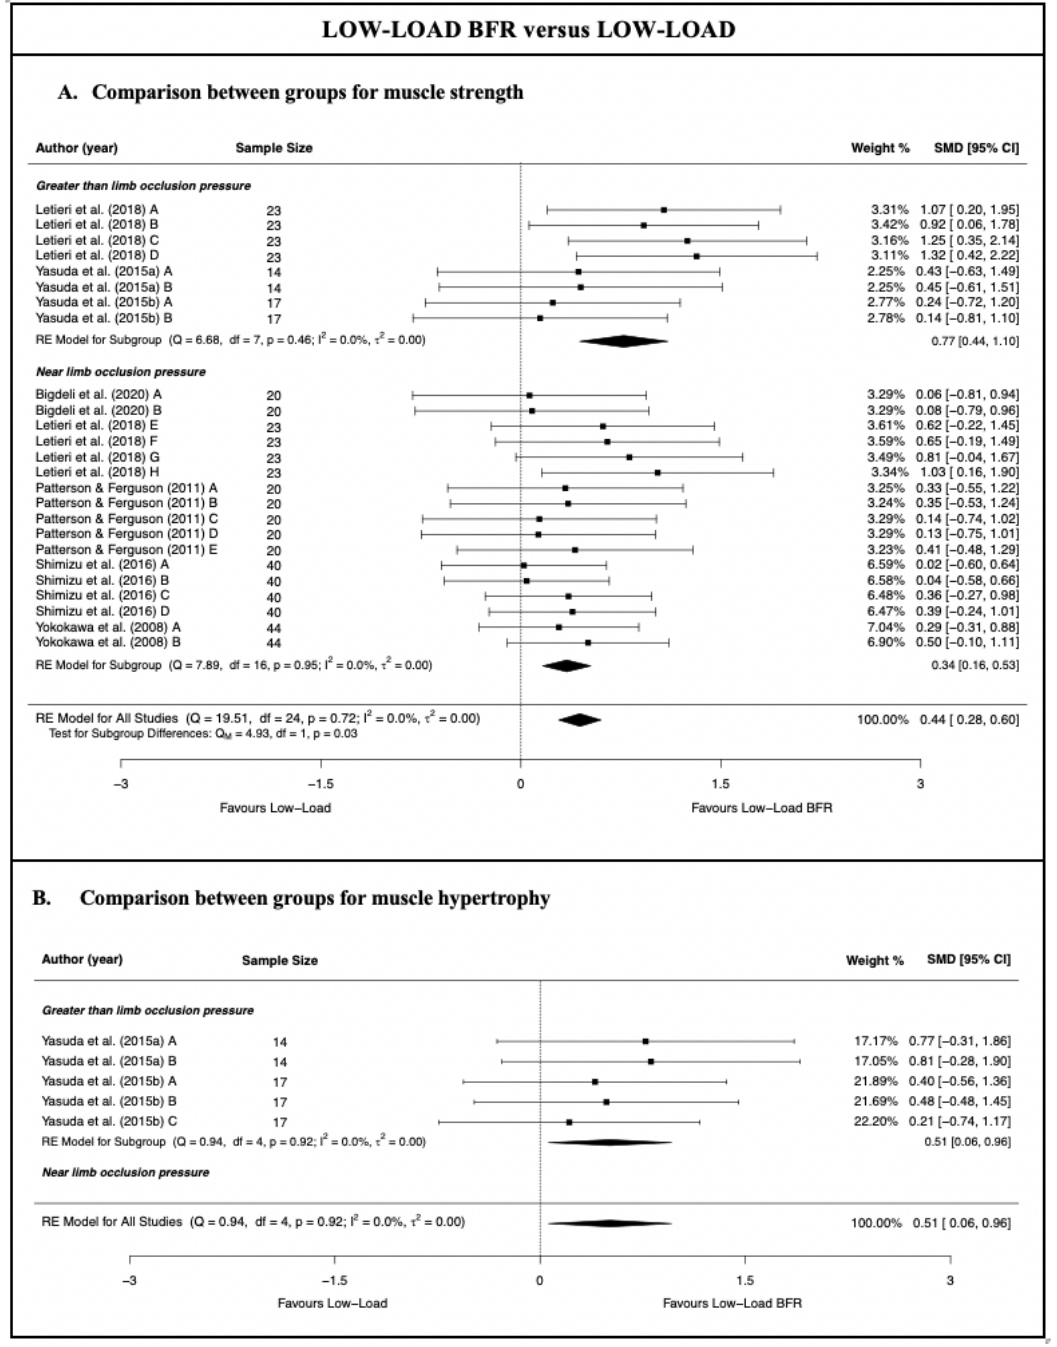
Figure 3. Synthesis forest plot for muscle strength and hypertrophy for low-load blood flow restriction training versus traditional low-load resistance training [28,57 – 62].